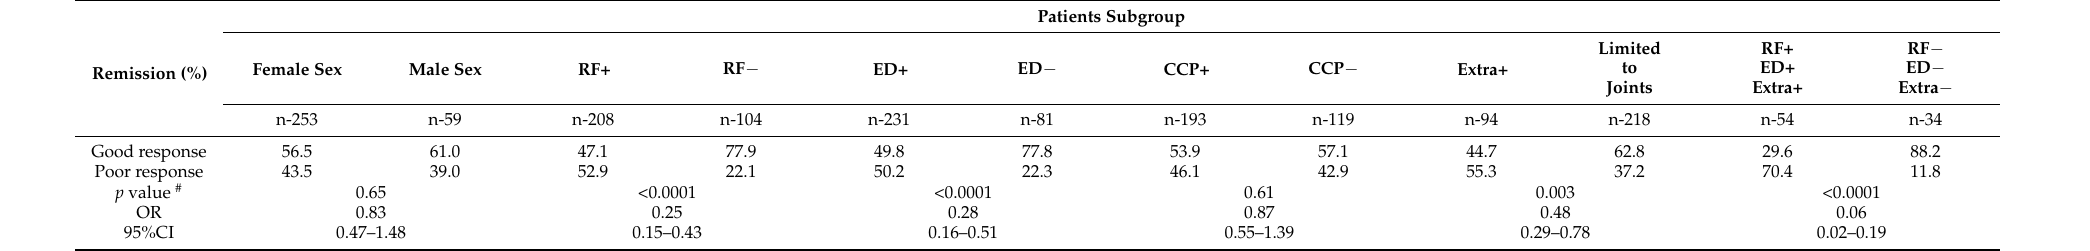
Table 3. Efficiency of MTX therapy depending on clinical